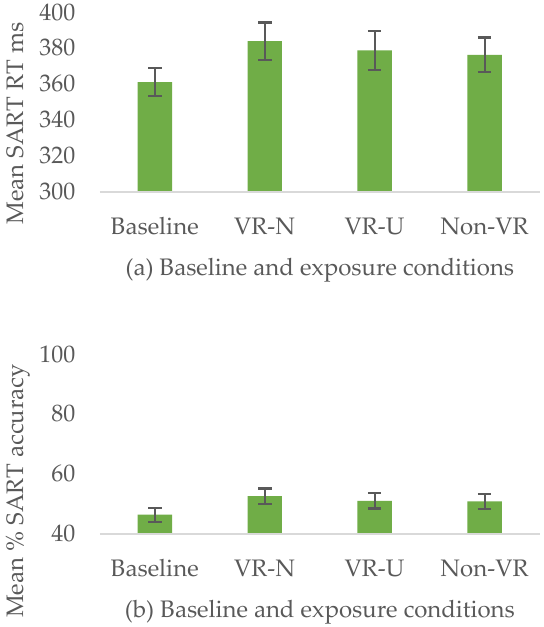
Figure 4. Comparison of mean SART scores at baseline and across three types of nature exposure on ( a ) mean response times and ( b ) mean percent accuracy. Error bars represent standard error.